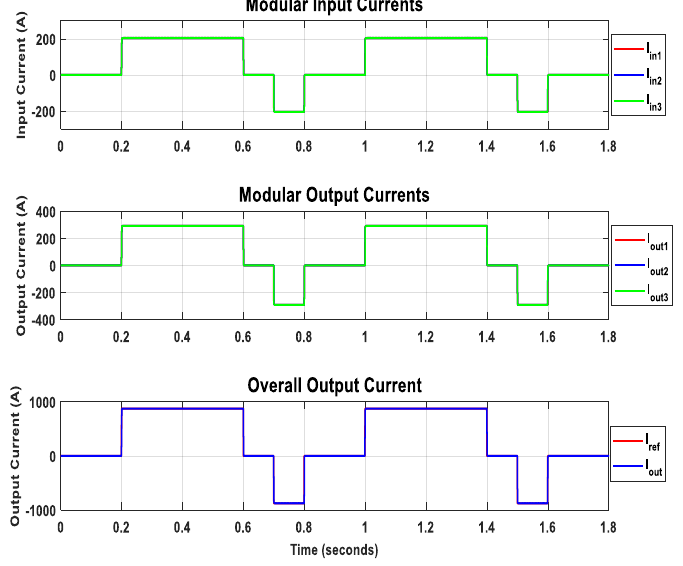
Figure 11. Simulation results for IPOP DC-DC converter.